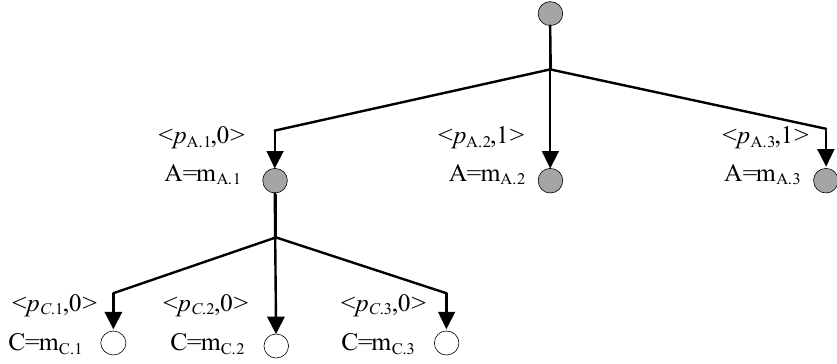
Figure 11. Search Tree of Conflict and Consistency Directed Local Sequential A* search (CCDLSA*)*.